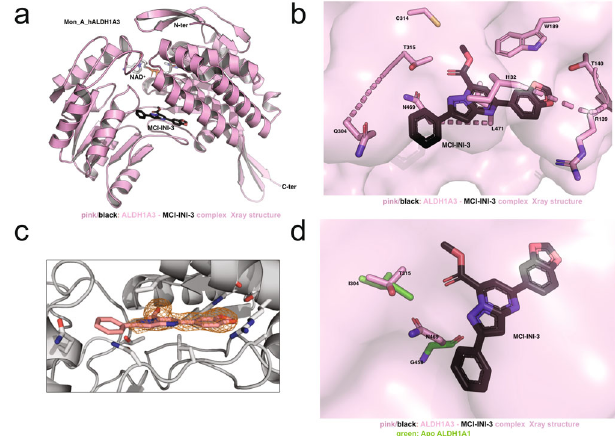
Fig. 7 Crystal structure analysis of ALDH1A3 in complex with MCI-INI-3. a Ribbon representation of the ALDH1A3 monomer structure. The ligands NAD + and MCI-INI-3 are shown as gray and black sticks. b Zoom-in of MCI- INI-3 binding site. The inhibitor is shown as black sticks and the residues de fi ning the binding pockets as pink sticks. c Omit Fo – Fc electron density map covering MCI-INI-3. The omit electron density map is shown in orange contoured at 2.5 standard deviations. d Superposition of the ALDH1A3 and ALDH1A1 structural elements responsible for MCI-INI-3 selectivity for ALDH1A3: N469 and T315 in ALDH1A3 (pink sticks) superimposed to the structurally equivalent G458 and I304 in ALDH1A1. MCI-INI-3 is shown in black sticks. All the images were prepared using the program